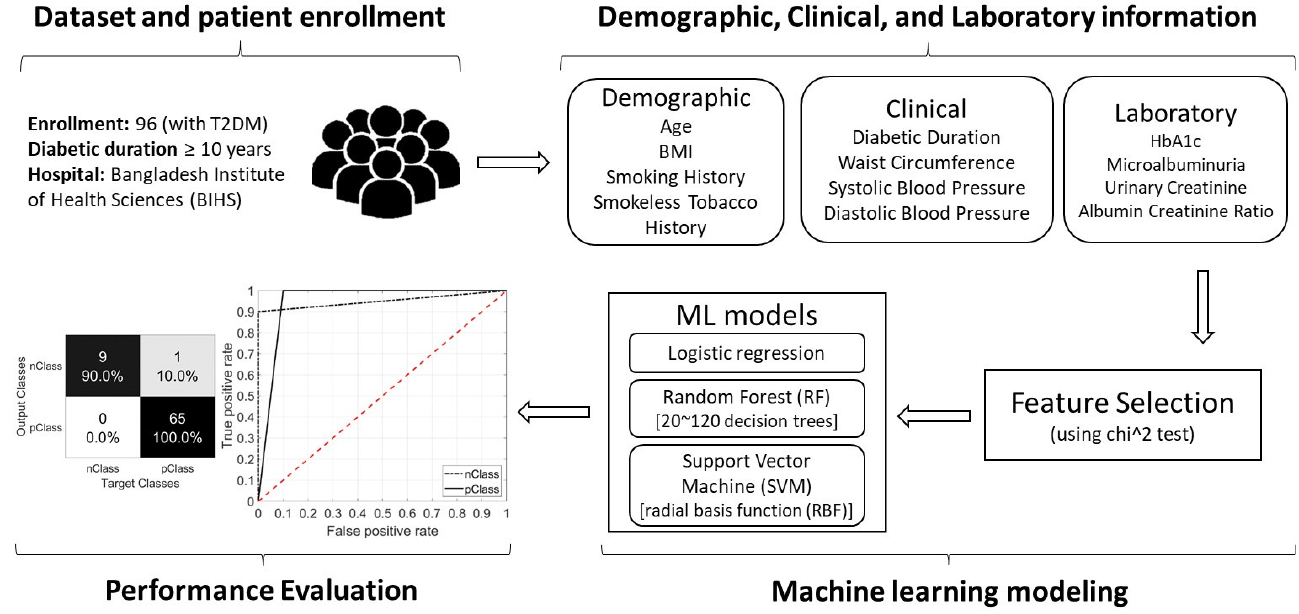
Figure 1. A graphical view of the complete research work in this study, including patient enroll- ment; demographic, clinical, and laboratory information acquisition; machine learning modeling; and performance evaluation of the